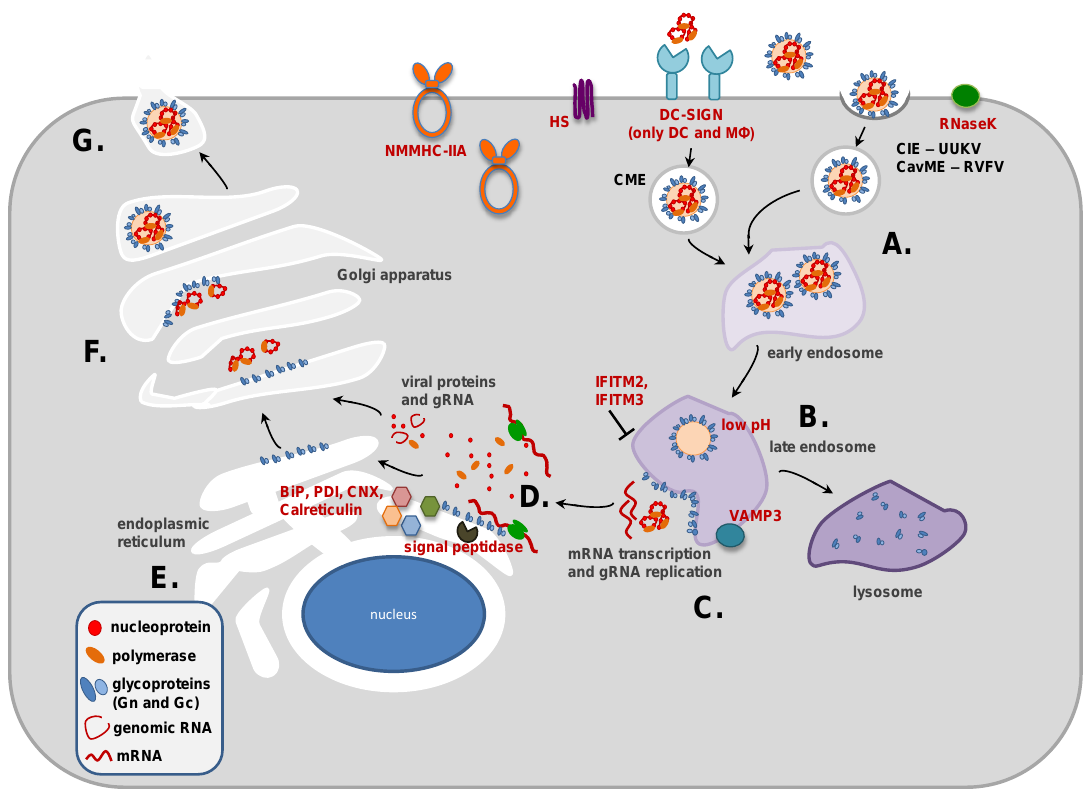
Figure 1. Replication cycle of phleboviruses. ( A ) Cellular attachment of phleboviruses is driven by glycoprotein interactions with host cell factors such as dendritic cell-specific intercellular adhesion molecule-3-grabbing non-integrin (DC-SIGN), heparan sulfate (HS), or non-muscle myosin heavy chain IIA (NMMHC-IIA). The binding to DC-SIGN and so far unknown entry factors induces uptake via caveolin-1-mediated endocytosis (CavME) (as for Rift Valley fever virus, RVFV) or incompletely defined clathrin-independent endocytic (CIE) mechanisms (as for Uukuniemi virus, UUKV). Ribonuclease kappa (RNaseK) promotes the internalization of virions by a yet unknown mechanism; ( B ) In late endosomes, the low pH induces the membrane fusion activity of the Gc protein. Expression of vesicle-associated membrane protein 3 (VAMP3) promotes UUKV penetration, while interferon-induced transmembrane protein (IFITM) 2 and IFITM3 inhibit the fusion of RVFV in late endosomes; ( C ) The fusion of viral and endosomal membranes allows release of the viral ribonucleoprotein complexes into the cytoplasm, the site of viral transcription and replication; ( D ) The viral glycoproteins Gn and Gc are translated at the rough endoplasmic reticulum (ER) as a precursor protein, Gn/Gc, which is cleaved by signal peptidase. The viral nucleoprotein and the viral polymerase are synthesized in the cytoplasm where they form together with newly produced genomic RNA (gRNA) ribonucleoprotein (RNP) complexes; ( E ) Binding immunoglobulin protein (BiP) and calnexin, two ER chaperones, are required for appropriate folding of Gn and Gc. Similarly, protein-disulfide-isomerase catalyzes Gn and Gc folding by promoting the formation of disulfide bonds, while calreticulin prevents misfolded Gn and Gc from being exported from the ER to the Golgi; ( F ) Correctly folded Gn/Gc heterodimers are transported into the Golgi apparatus where they associate with RNPs via the cytoplasmic tails of Gn during the budding process; ( G ) After budding of new virus particles into the Golgi is complete, virus-containing vesicles are transported to the plasma membrane where the virions are released by exocytosis. DC: dendritic cell; M φ : macrophage; CME: clathrin-mediated endocytosis; PDI: protein disulfide isomerase; CNX: